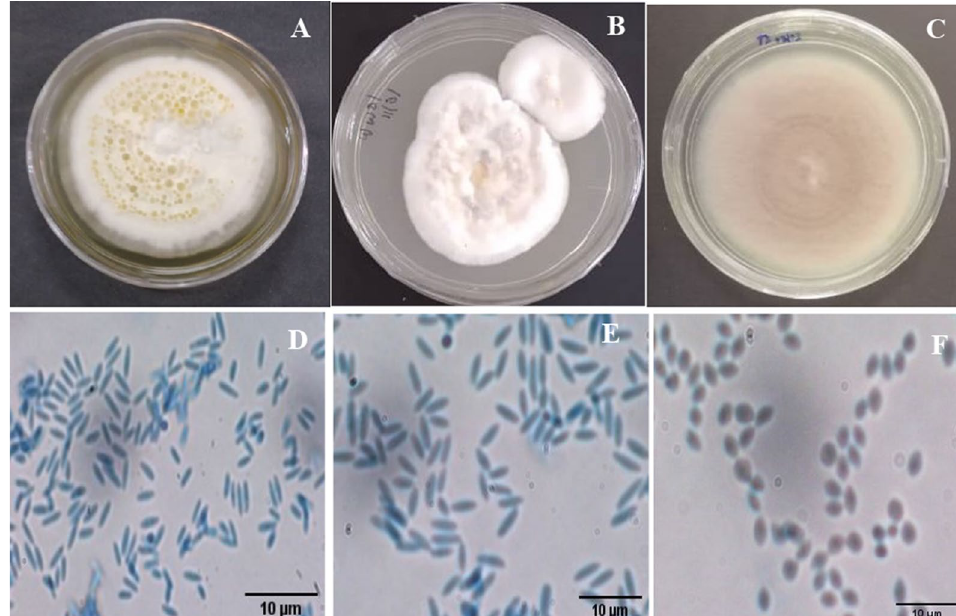
Fig. 1 Colony morphology of Isaria javanica and Purpureocillium lilacinum isolated from infested whitefly ( Bemisia tabaci ) on PDA media at 25 °C after 10 days of growth A Colony of I. javanica (Cjw-01) B Colony of I. javanica (Cjc-03) C Colony of P. lilacinum (TS-01) D Conidia of I. javanica (Cjw-01) E Conidia of I. javanica (Cjc-03) F Conidia of P. lilacinum (TS-01)